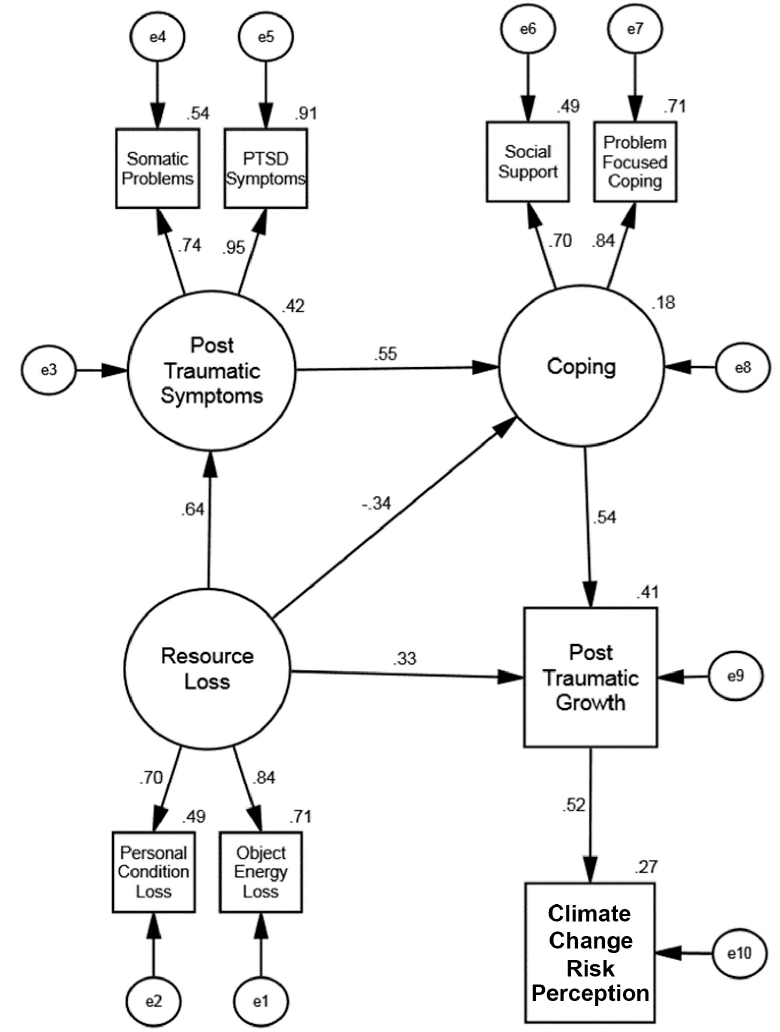
Figure 2. (Study 1: Philippines) . Final Structural Equation Model: Influence of Resource Loss on Posttraumatic Symptoms, Coping, Posttraumatic Growth, and Climate Change Risk Perception. The offset values on endogenous variables are R 2 effect sizes. While not shown here, the error terms e2 and e6 were allowed to correlate ( r = − 0.34).